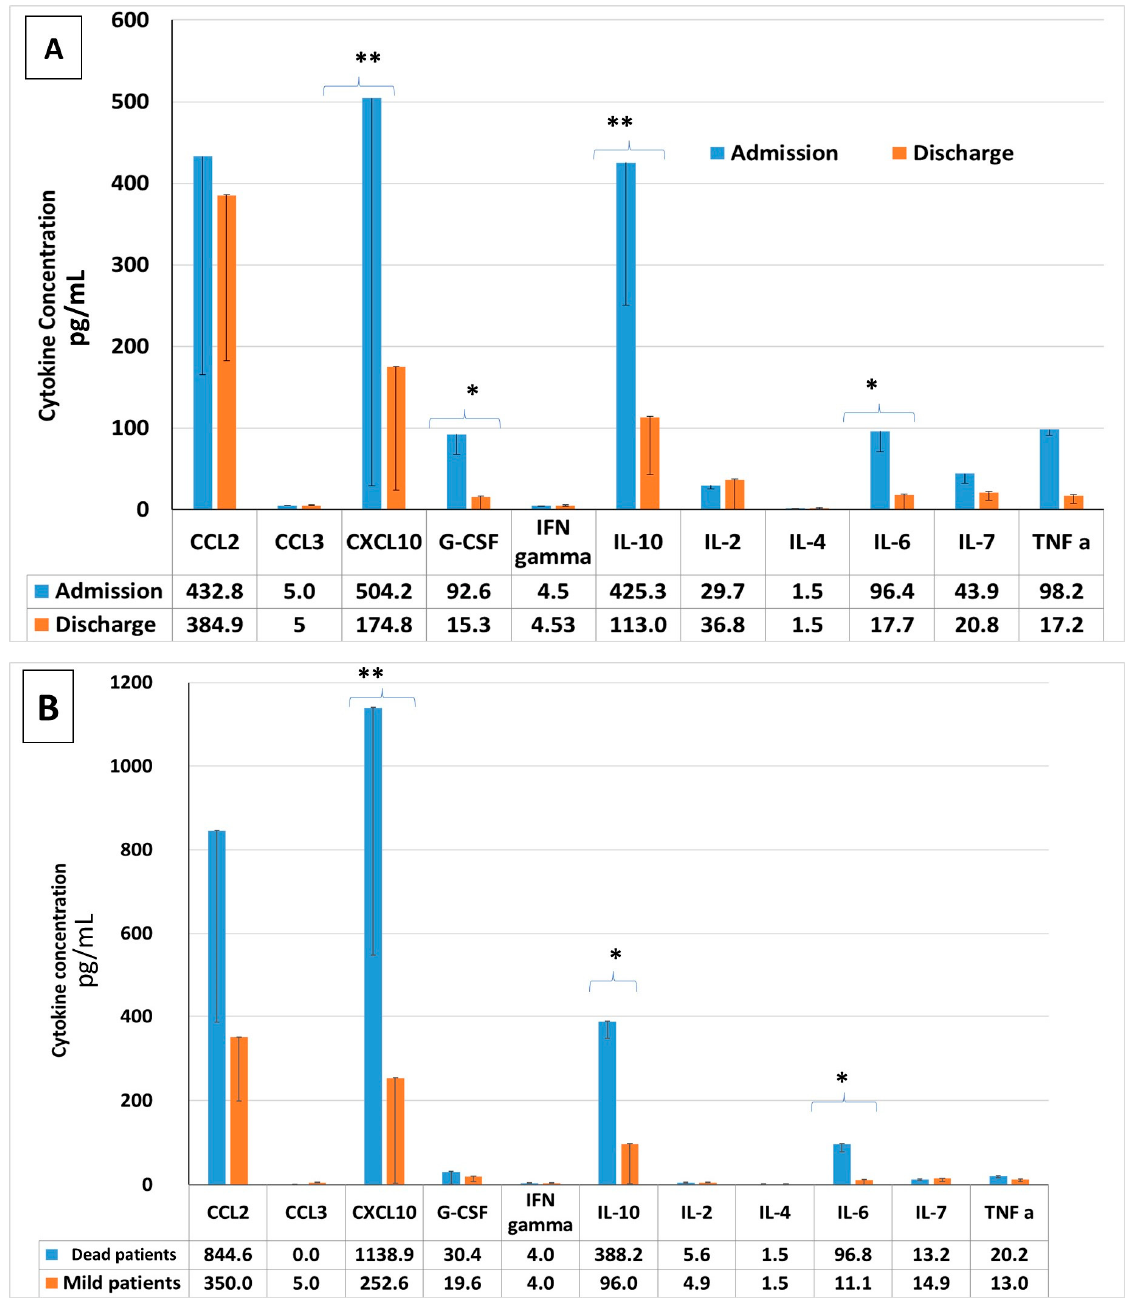
Figure 3. Cytokines levels in COVID-19 patients: The cytokines measured are CCL-2, CCL-3, CXCL-10, GCSF, IFN-gamma, IL-10, IL-2, IL-4, IL-6, IL-7 and TNF α . Cytokine levels were measured upon admission and upon discharge, in severely ill and mildly ill patients, and also between survivors and those not surviving. ( A ): Cytokine levels upon admission vs. upon discharge. ( B ) survivors vs. non-survivors. * p < 0.05, ** p < 0.001.